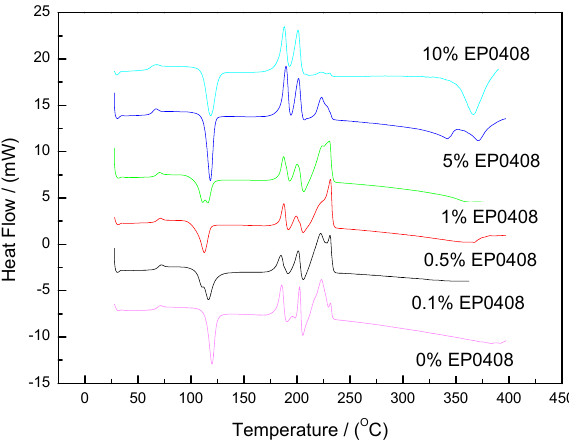
Figure 2. Differential scanning calorimetry (DSC) scans of phthalonitrile monomer (2 wt % BAPP mixtures with 0, 0.1, 0.5, 1, 5, and 10 wt % of EP0408 added at 260 °C).